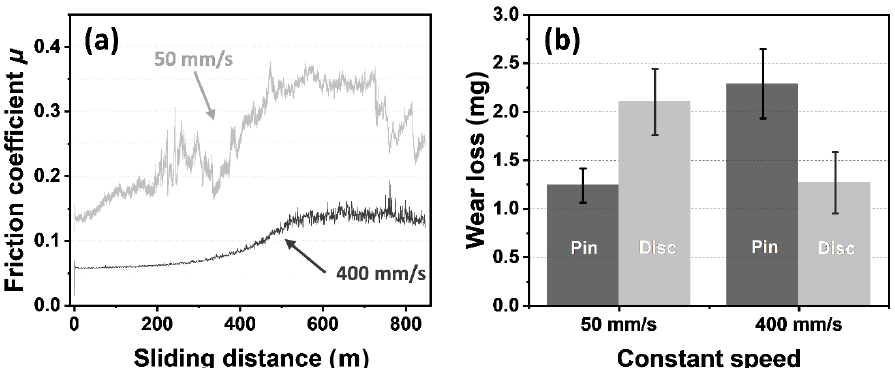
Fig. 4 Results for the 5 µm slurry at constant sliding speeds of 50 and 400 mm/s for a maximum sliding distance of 846 m: (a) friction coefficient as a function of sliding distance; (b) wear results of pin and disc for the two constant speeds.